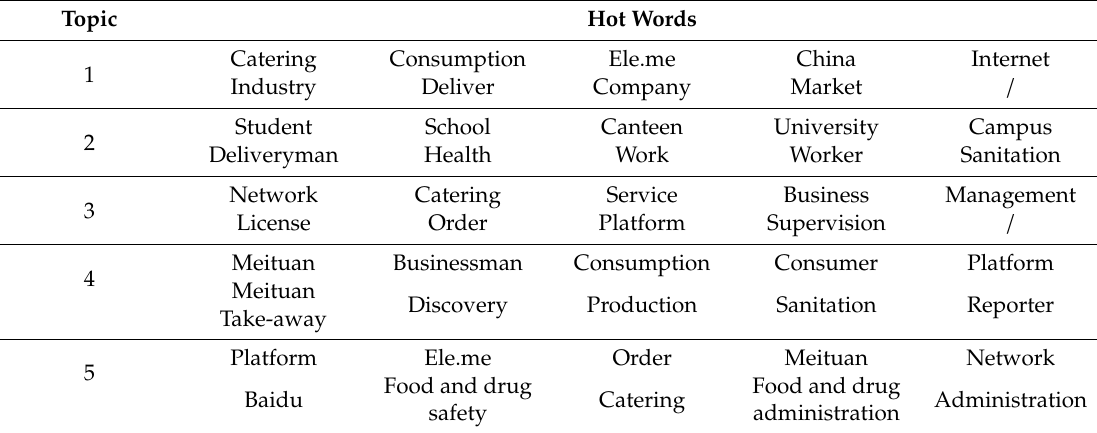
Table 4. Topic distribution table.